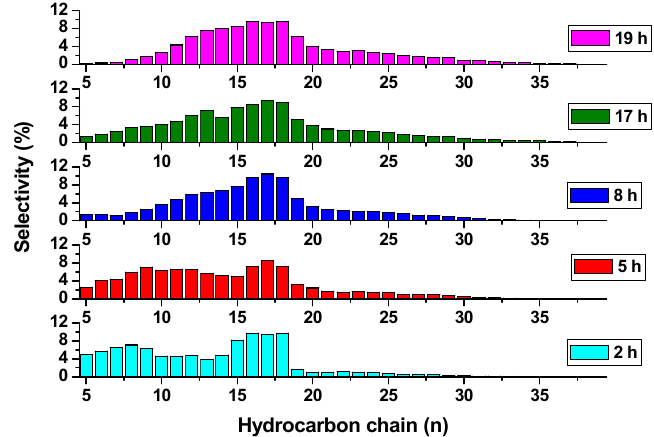
Figure 5. Catalyst selectivity from liquid ‐ sample analysis at various TOS for reaction performed at